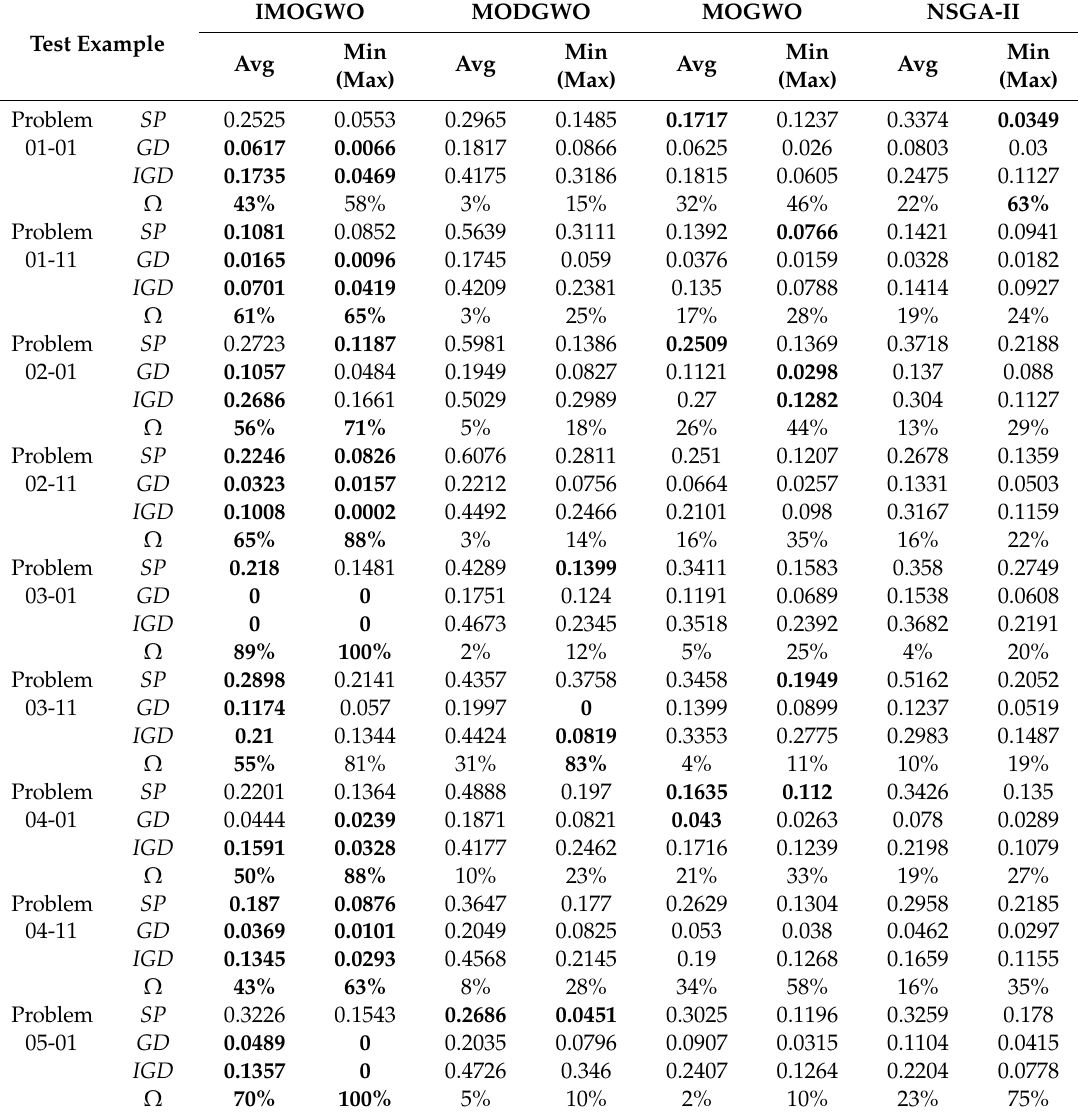
Table 6. Experimental results comparison of four algorithms with two